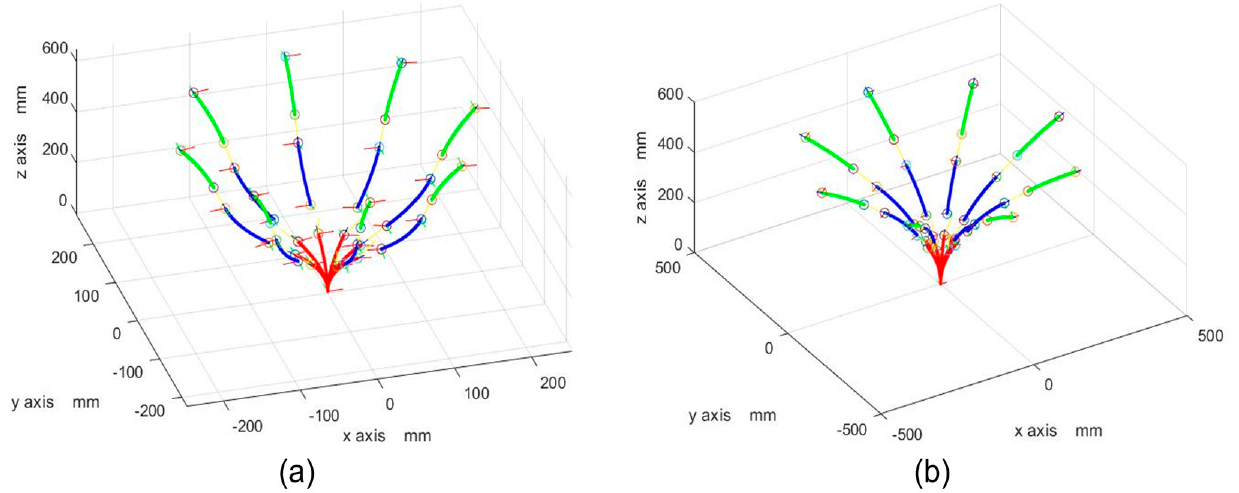
Figure 12. Kinematic simulations of the flexible manipulator: ( a ) same rotation angle 𝜑 in three segments, ( b ) rotation angle 𝜑 in the first segment (red) and third segment (green), rotation angle 𝜑 + 𝜋 in the second segment (blue).